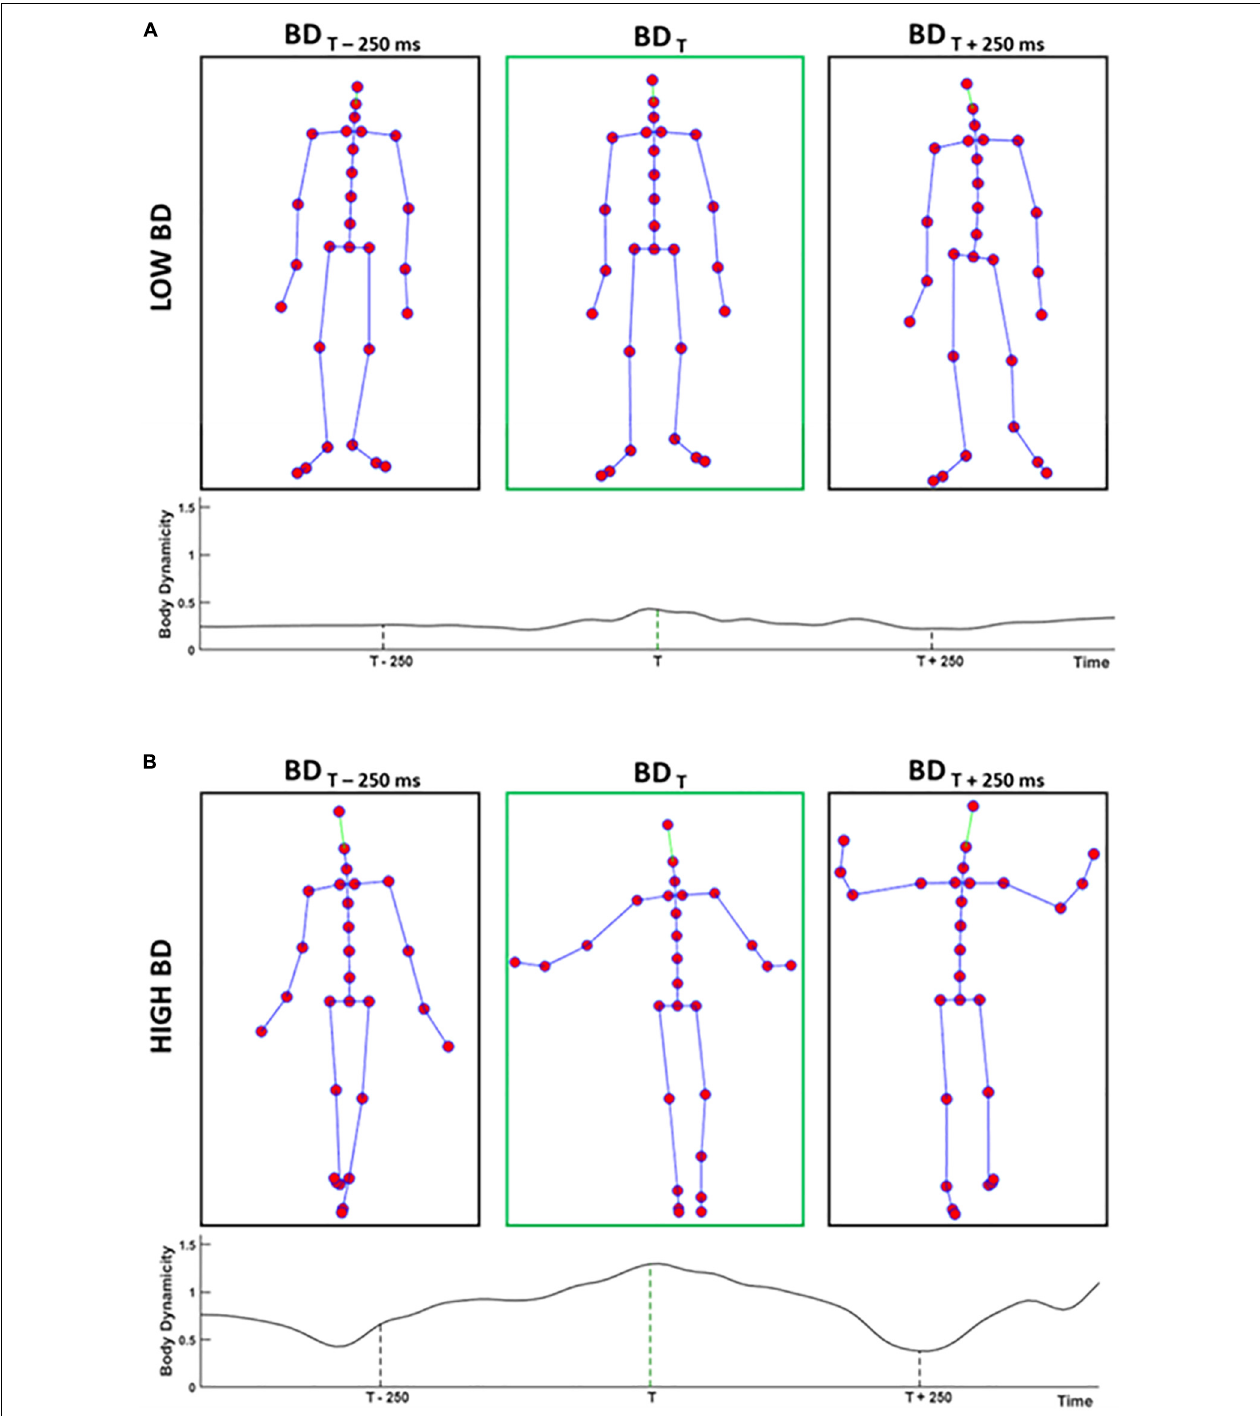
FIGURE 2 | Panels (A,B) show three body joints configurations depicting body postures with low (high) level of BD extracted from two different walkings. The BD time course of the walking is reported below each panel, which shows the precise timepoint from which postures are extracted. Middle panels in green illustrate the representative frames of the whole kinematic, extracted according to the procedure described in the Section “Materials and Methods.” Instead, the first and third panels of the two rows represent two frames extracted 250 ms before and 250 ms after the time of the representative BD, respectively.